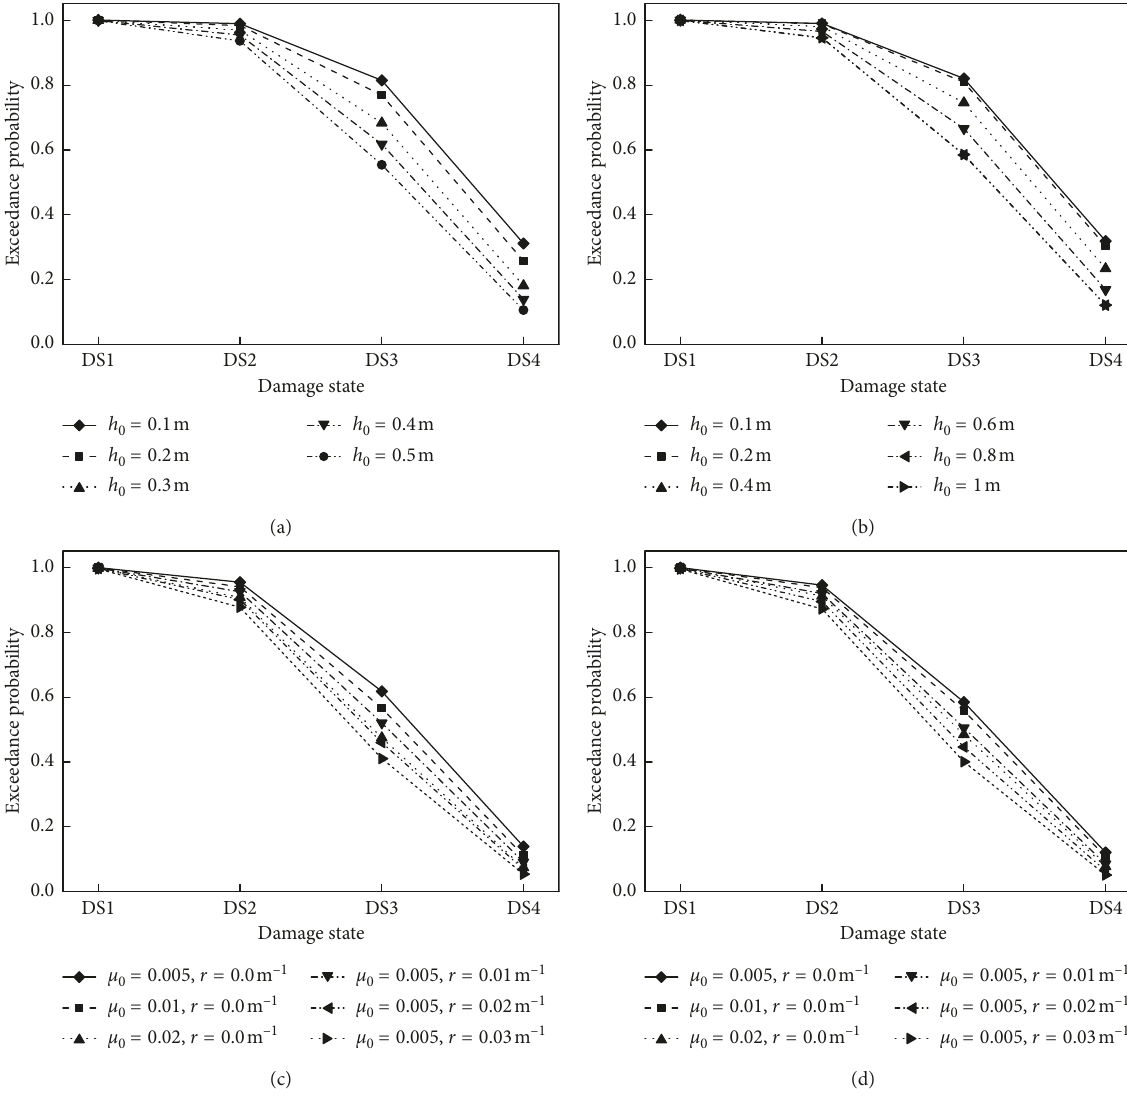
200kN/m, C 0kN s/m, and PGA (cid:31) (cid:31) · . 0m, h . 1 (cid:31) 1 0 (cid:31) 0